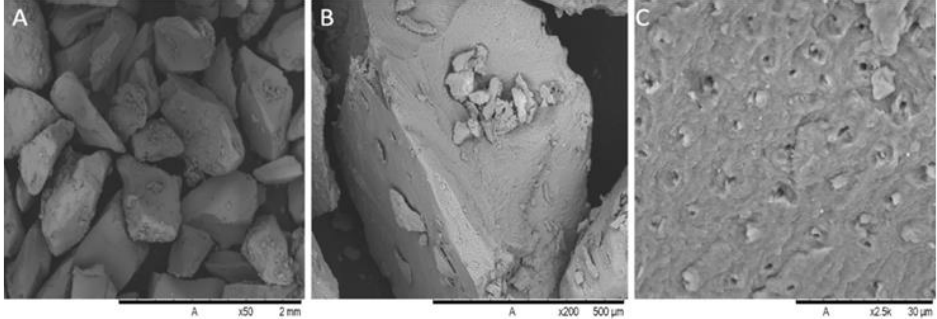
Figure 2. SEM images of ATDM granules at different magnifications: ( A ) 50×; ( B ) 500×; ( C ) 2500×.